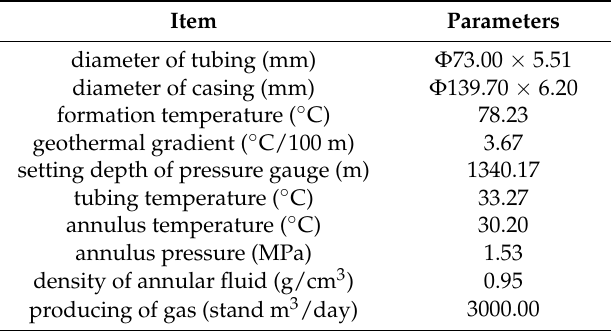
Table 3. Main parameters of the test Table 3 Main parameters of the test well.